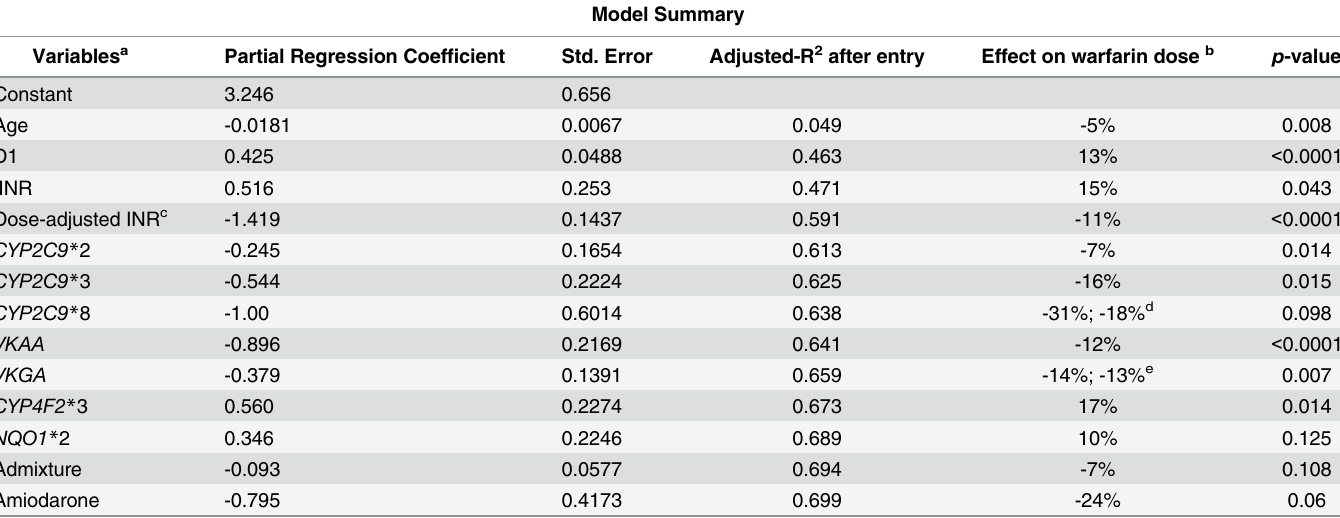
Table 3. Summary of attributes of the pharmacogenetic equation for warfarin dosing refinement in Caribbean Hispanics. Derivation cohort (n = 255 patients from the VACHS).